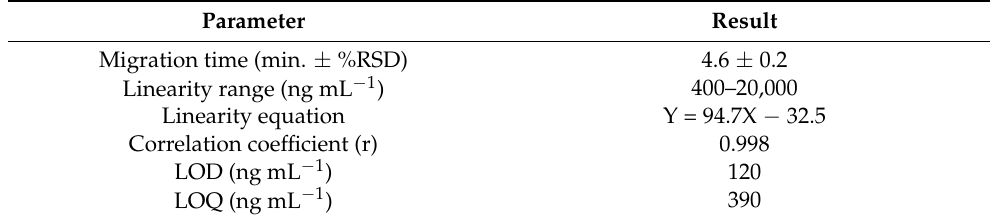
Table 1. Linearity and regression results for determination of Ni II (3-OMe-salophene) using the proposed CZE method.